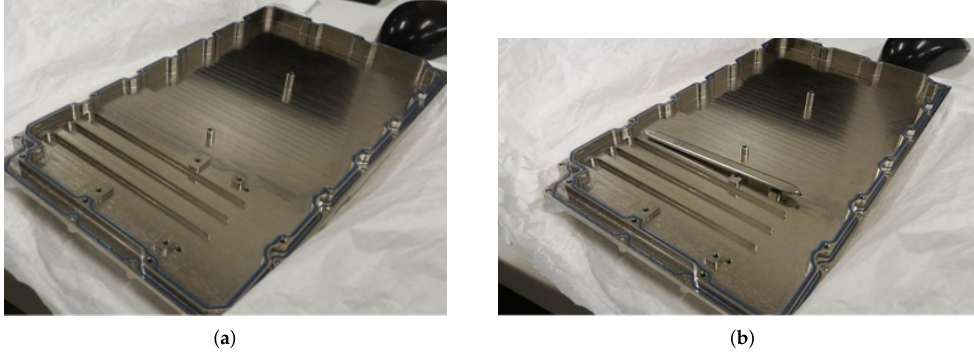
Figure 3. Test device ( a ) Aluminum chassis. ( b ) Heat pipe